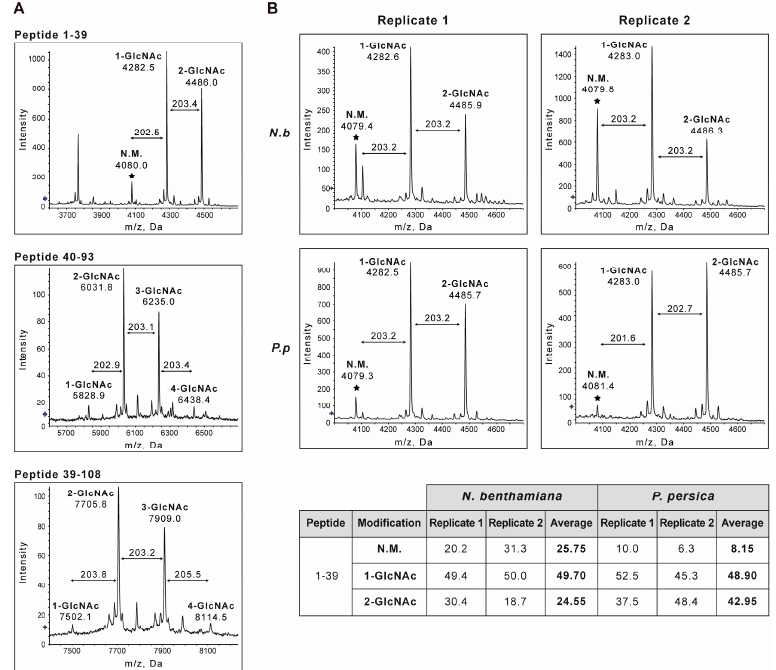
Figure 2. The O -GlcNAcylation pattern of the coat protein (CP) of Plum pox virus (PPV) in virions purified from Prunus persica . ( A ) Matrix-assisted laser desorption / ionization-time flight (MALDI-TOF) spectra showing peaks corresponding to di ff erent species of peptides 1–39, 40–93, and 39–108 of PPV CP. ( B ) Comparison of MALDI-TOF spectra showing peaks corresponding to di ff erent species of peptide 1–39 from PPV virions produced in Nicotiana benthamiana ( N.b ) and P. persica ( P.p ). The table shows relative accumulations of the species of peptide 1–39 non-modified (N.M.), mono- O -GlcNAcylated (1-GlcNAc), and di- O -GlcNAcylated (2-GlcNAc). O -GlcNAcylation levels were estimated from the peak intensities ( Y -axis) and calculated by dividing each maximum signal intensity by the sum of those of all peptide species (average values of two biological replicas). In both ( A ) and ( B ), mass / charge ratios ( m / z ) assigned to relevant peaks, di ff erences in mass among peaks attributed to O -GlcNAc groups, as well as predicted number of O -GlcNAc residues modifying each peptide species, are depicted. The asterisk marks the unmodified peak (N.M.) of each tryptic peptide.